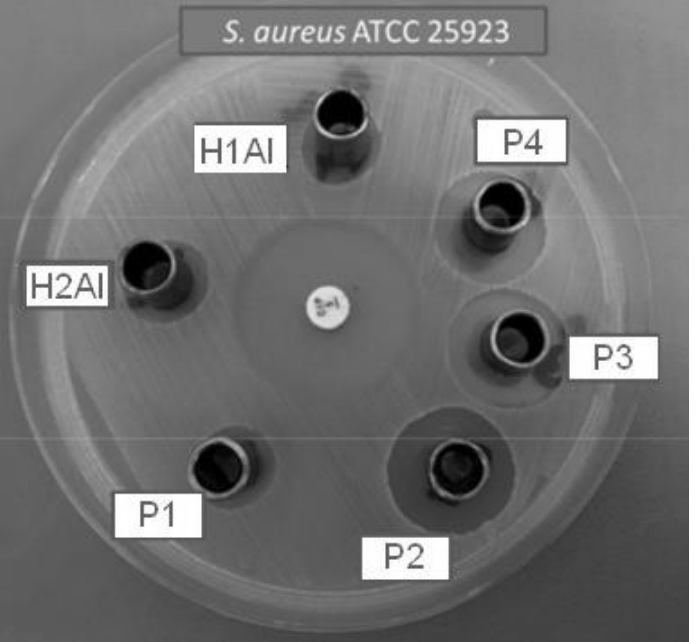
Figure 14. Antibacterial activity of tested compounds (H1 – H2 and P1 – P4) against S. aureus ATCC